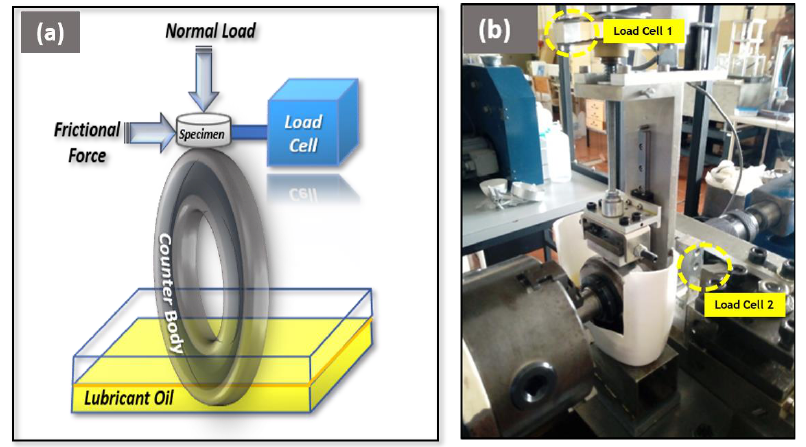
Figure 3. Tribometer used during experiments: ( a ) Schematic diagram of the block-on-ring configuration; ( b ) Tribometer showing the two load cells (1 — load cell to measure normal force, 2 — load cell to measure tangential force) and the contact conditions.